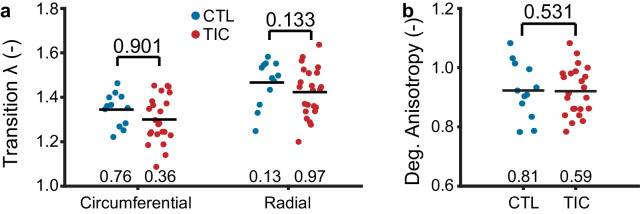
Biaxial curves between control (CTL, blue, n = 11) and tachycardia-induced cardiomyopathy (TIC, red, n = 23) exhibited comparable anisotropies.(a) Comparisons of the transition stretch in circumferential and radial directions, defined as the stretch at which collagen engagement begins (i.e, the heel stretch). (b) Comparisons of the degree of anisotropy, defined as the ratio between circumferential and radial stretches at which 20 N/m membrane tensions are achieved under equibiaxial loading. Black bars represent data mean if normal, and data median if non-normal as determined by Shapiro-Wilk test: p-values below data. Values above data represent p-values from Student’s t-test.